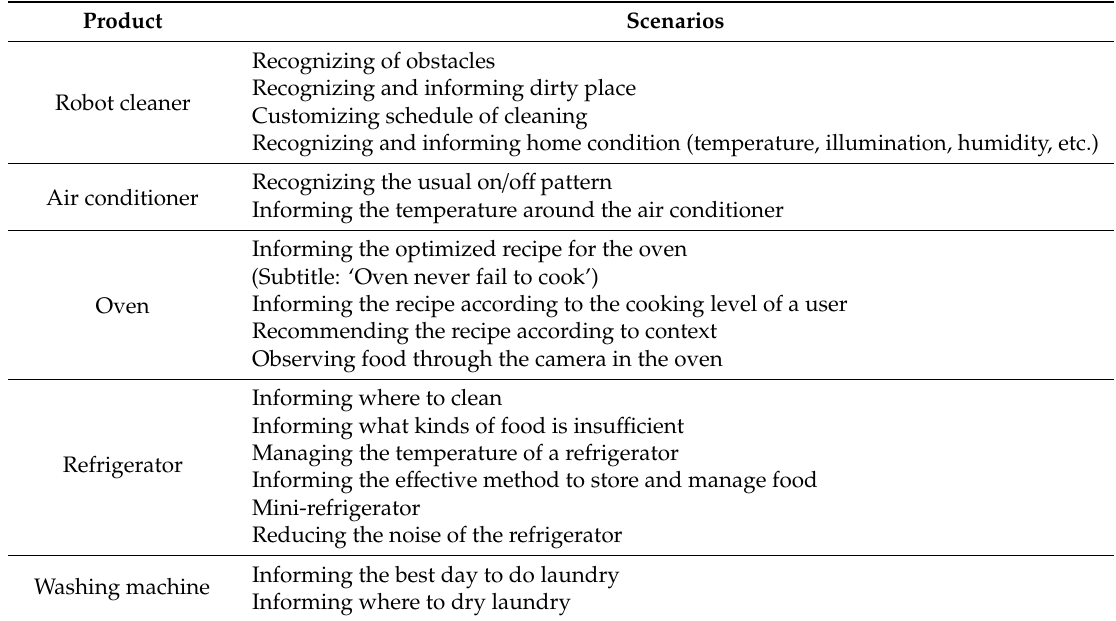
Table 5. Scenarios for 5 home